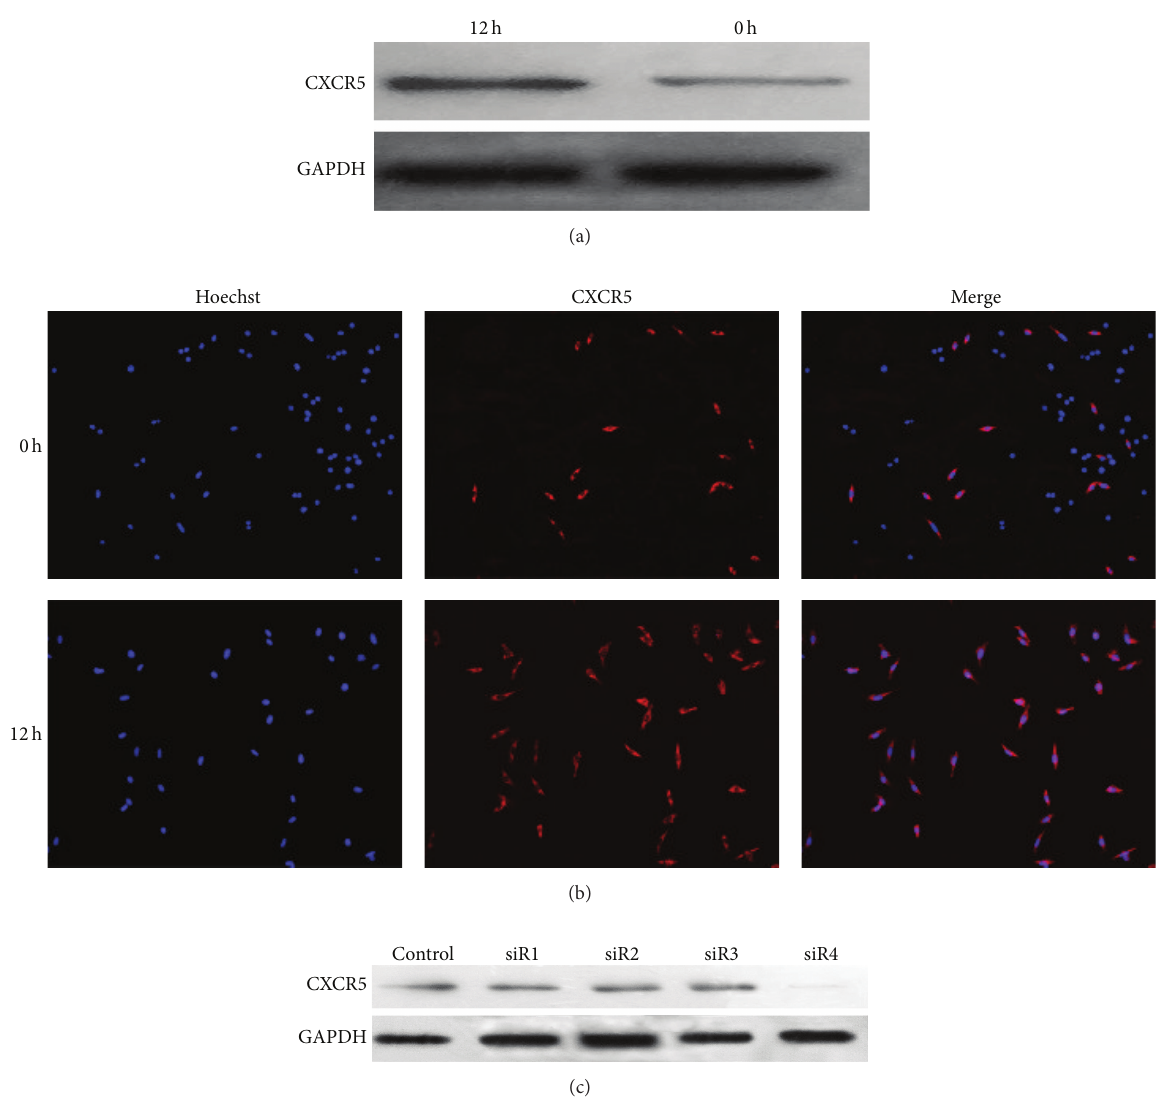
Figure 3: Positive expression of CXCR5 in HRMCs. (a and b) Western blot and immunofluorescence showed CXCR5 expression whether under stimulation of CXCL13 or not. (c) Transfection by siR4 was